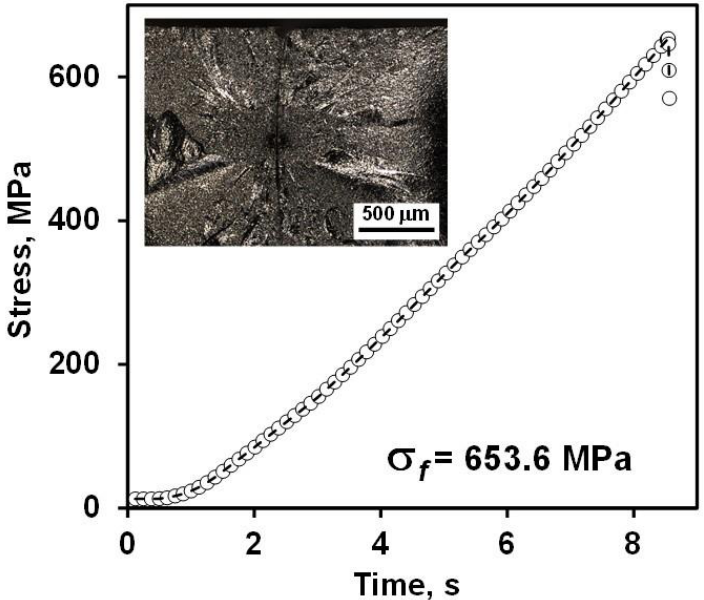
Figure 8. Stress vs time loading plot of B 4 C for flexure strength measurements. The insert shows an optical micrographs of fracture surface of B 4 C after failure.